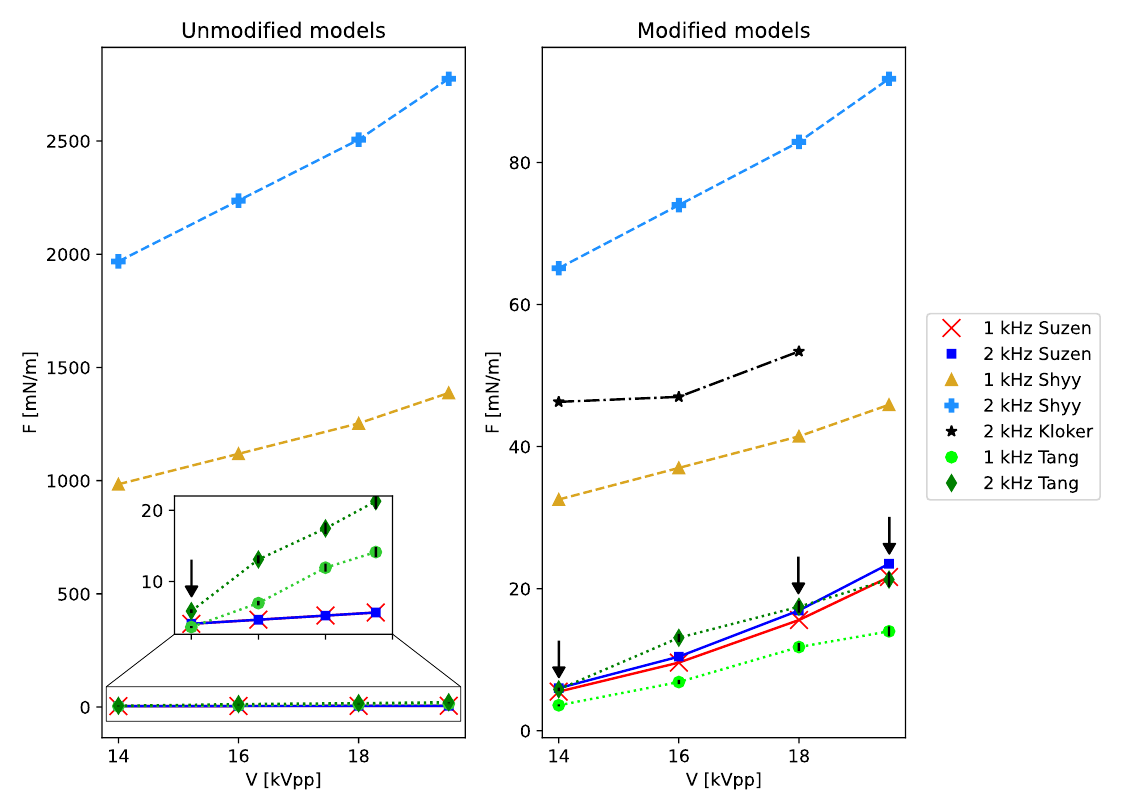
Figure 10. Effect of voltage and effect of frequency (case 2 setup) on the force, unmodified models on the left, modified models on the right. The black arrows show where the numerical results are close to the reference